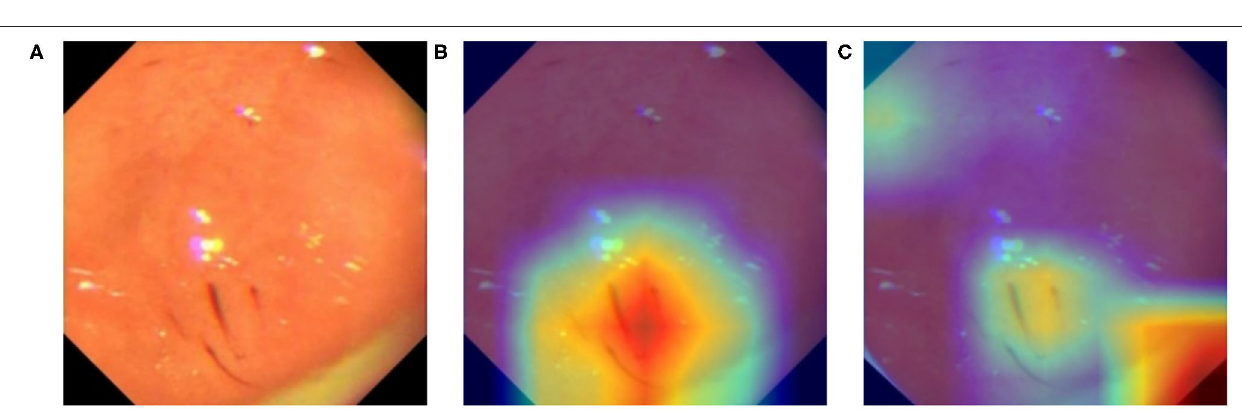
We labeled diseased images from dataset A and B with different colors to highlight the different feature representations from different data sources. We observe from Figure 7A that for 2- class classification, the diseased and healthy images are well separated in the 2-dimensional PCA plot, and the images from dataset A and B also fall in different regions. For 3-class and